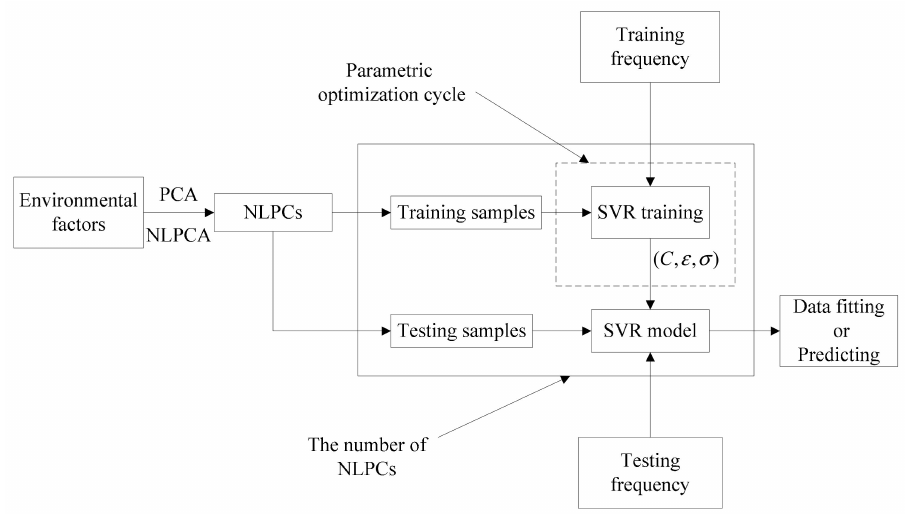
Figure 3. Flowchart of the NLPCA-SVR.